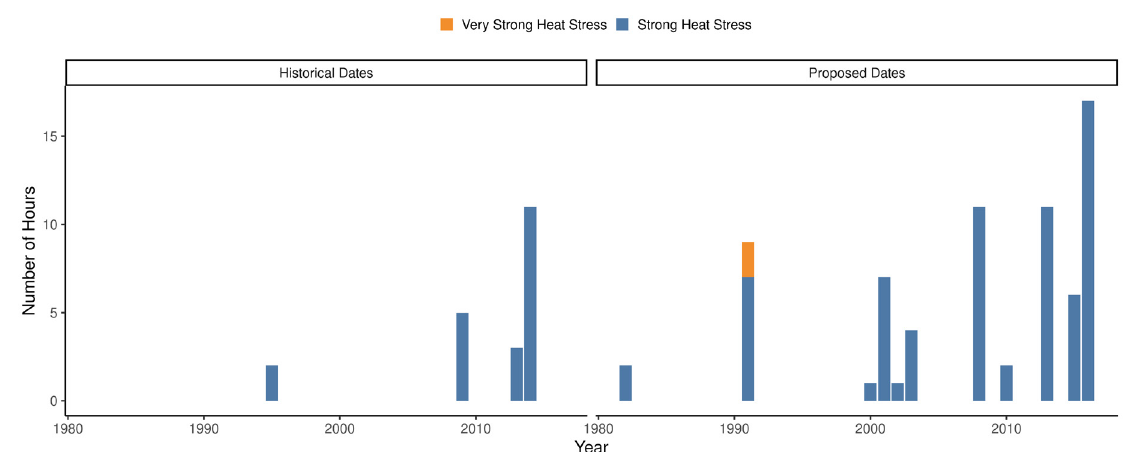
Figure 4: The distribution of heat stress hours, accumulated along all three reference points, for past events and the proposed event date.